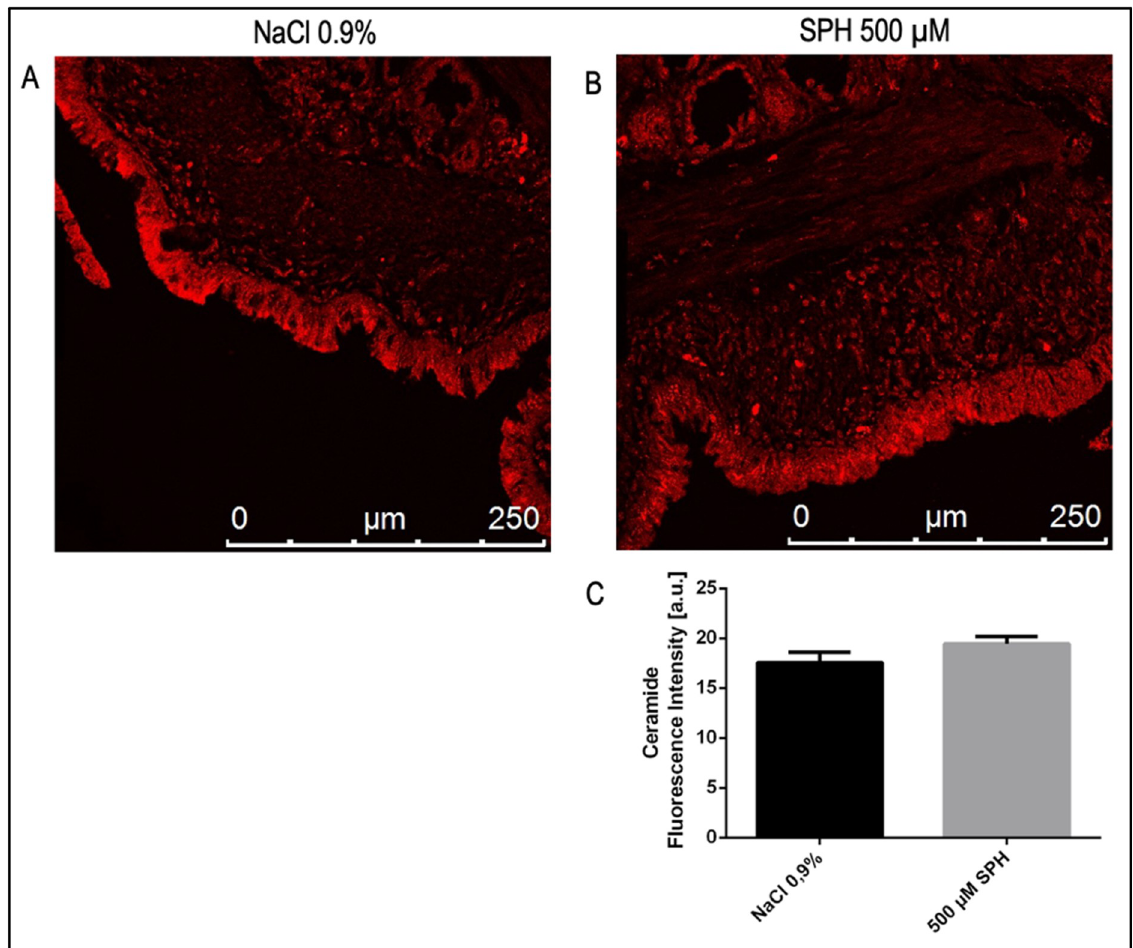
Fig 6. Histological studies of lungs stained with Cy3-coupled anti-ceramide antibodies. No differences in ceramide of BEC were detected after sphingosine inhalation (n = 5 pigs) compared to saline (NaCl 0.9%) inhalation (n = 4 pigs) (A, B). Quantitative analysis of the fluorescence intensity of a total of 1200 cells per group (C). Given is the mean ± SD of ceramide fluorescence intensity from each 3 sections with analysis of fluorescence intensity in epithelial cells within 5 visual fields per animal (n = 4 for the control group and n = 5 for the sphingosine group), p < 0.05 was considered as significant; students t-test/ Mann-Whitney-u-test.